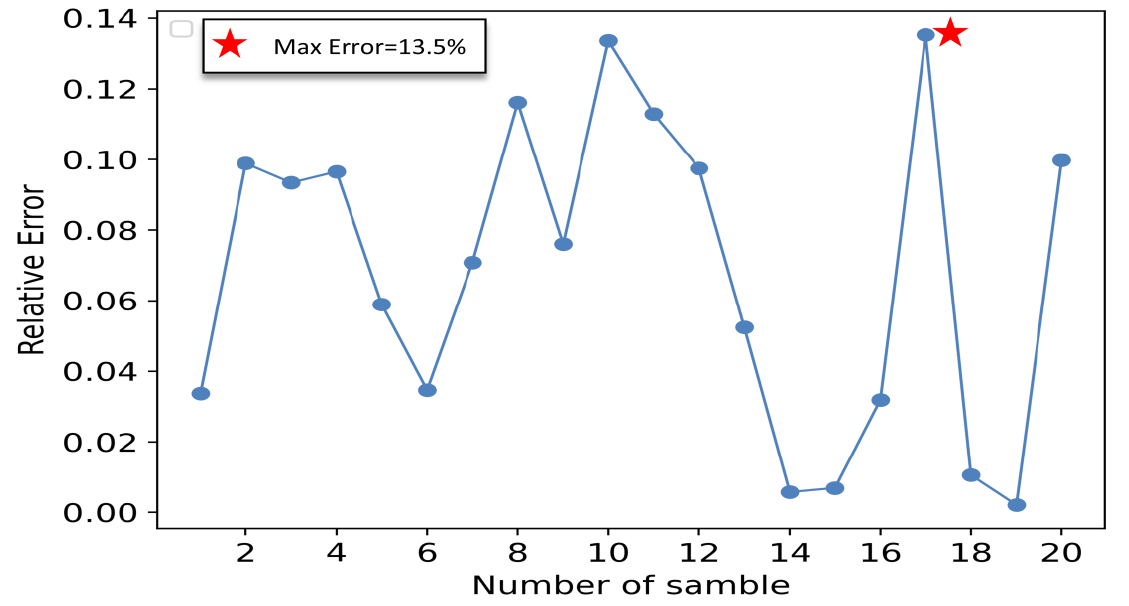
Figure 10. Relative error of the IGWO-SVR model for each individual sample point.